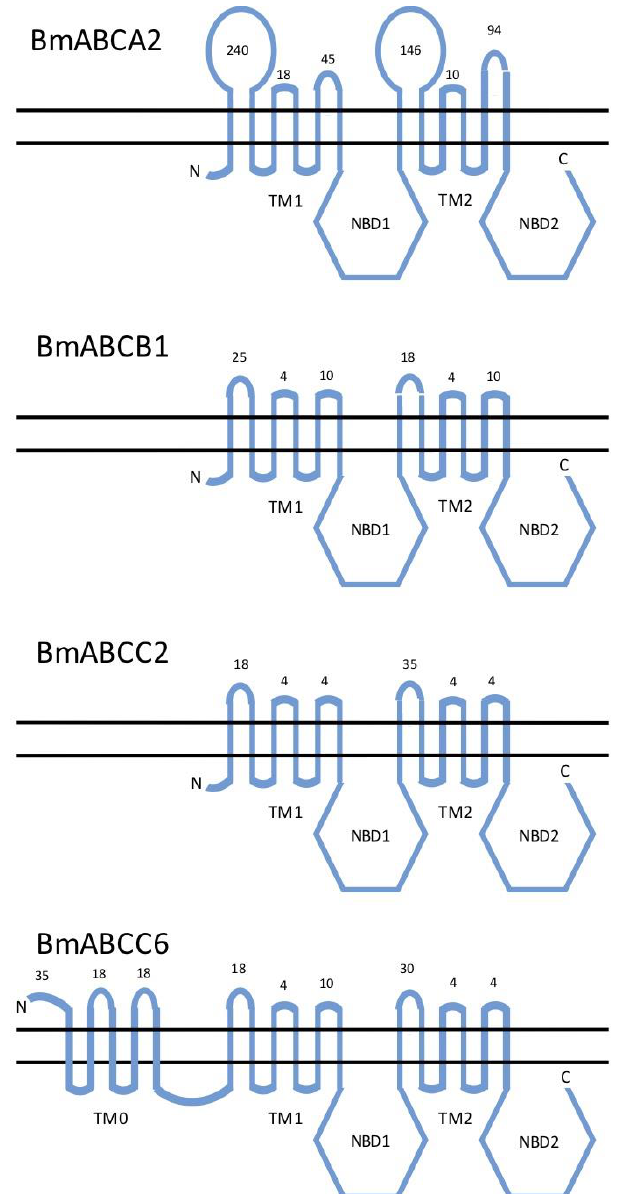
Figure 2. Phobius [10,11] predictions of membrane topology in the lipid bilayer of four ABC transporters from Bombyx mori orthologous to those interacting with three-domain Cry proteins described in the text (not to scale). The external lumenal surface is on top. Numbers of residues in each predicted external loop are shown. Transmembrane domains: TM0, TM1, and TM2. Nucleo- tide-binding domains: NBD1, NBD2. The N-terminus and C-terminus of each polypeptide is indi-